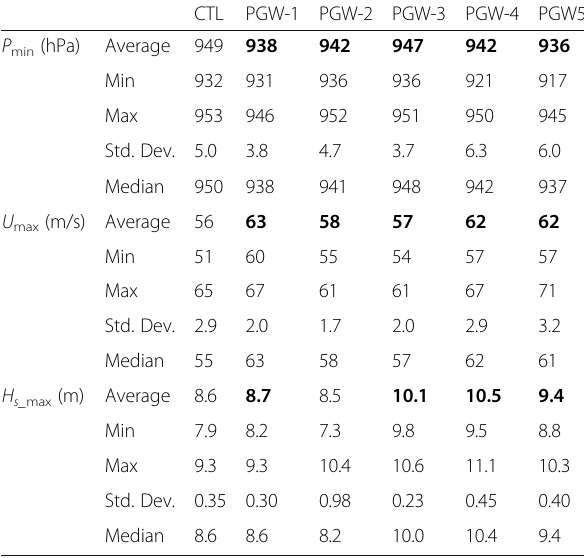
Table 7 Summary of the WRF and WW3